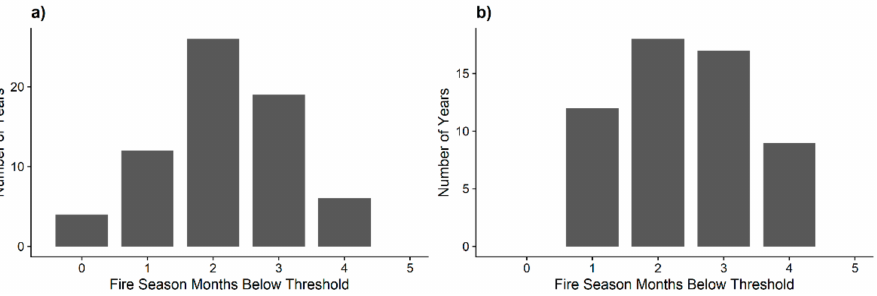
Figure 6. Characterization of forest fire season based on river flows. Frequency of the number of summer (November-March) months in the historical river gauge records fire for the ( a ) Franklin River and ( b ) Davey River when flows were below the median probability of forest fires occurrence in the respective surrounding ecohydrological domains identified by this